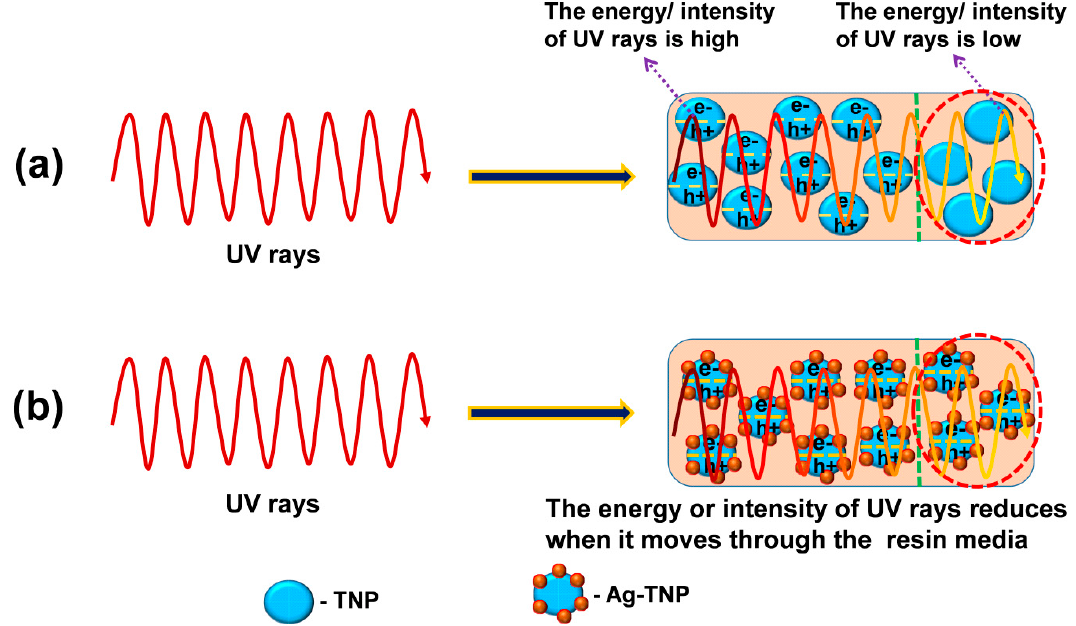
Figure 12. The proposed induced photopolymerization mechanism of SLR / nanofillers schematic illustration of UV light penetration through the ( a ) SLR / high energy bandgap semiconducting NPs (e.g., TiO 2 ) (the dotted red circles represents there is no possible electron hole pairs generation when the UV intensity decreases), and ( b ) SLR / low energy bandgap semiconducting NPs (e.g., Ag-TNP) (the dotted red highlights demonstrates that, the successful electron–hole pairs formation even at lower intensity of UV lights). The energy / intensity of UV rays reduces (the red color lines indicate higher intensity and pale yellow color lines indicates lower intensity) when it undergoes deep penetration through the resin composites.